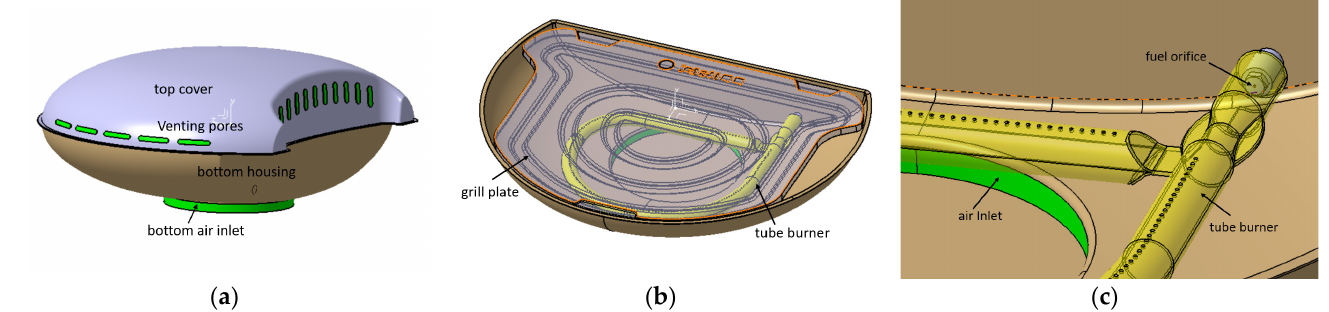
Figure 3. Simulated furnace structure. ( a ) Furnace appearance; ( b ) Combustion System; ( c ) Fuel or- ifice.